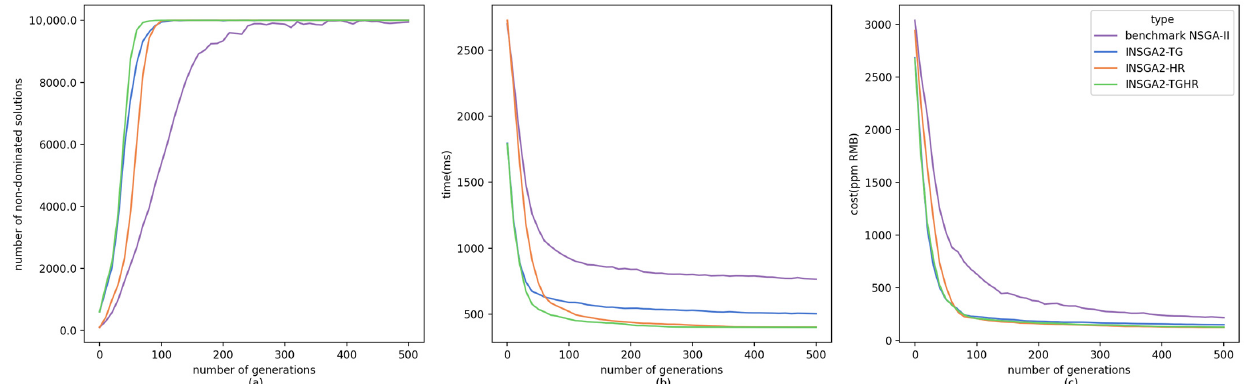
Figure 8. Comparison of evolution generations. ( a ) The relationship between evolutionary generations and non-dominant solutions; ( b ) The relationship between evolutionary generations and low-time Extremum; ( c ) The relationship between evolutionary generations and low-cost Extremum.